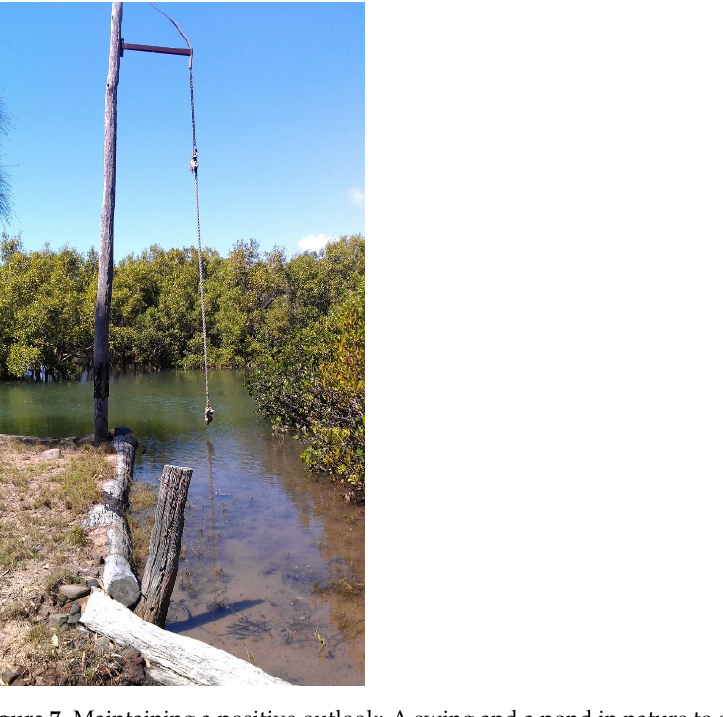
Figure 7. Maintaining a positive outlook: A swing and a pond in nature to show positive memories of home along with sense of familiarity.